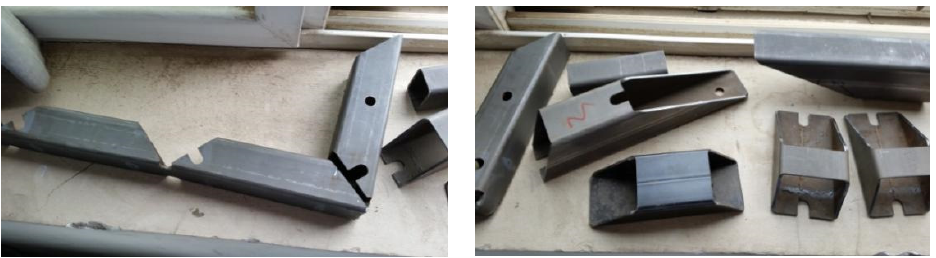
Figure 8. The geometry of some of the parts.